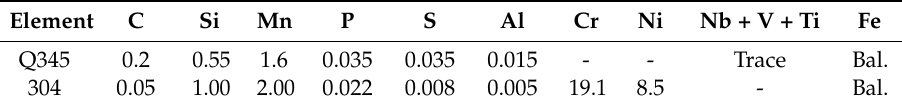
Table 1. Chemical composition of clad plate materials (mass fraction %).